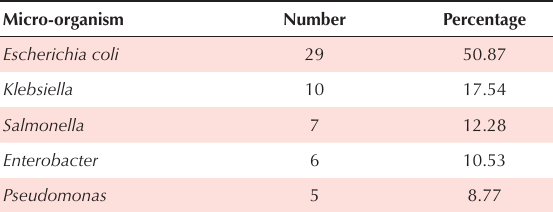
Table 3. Micro-organisms isolated in peritoneal fluid culture